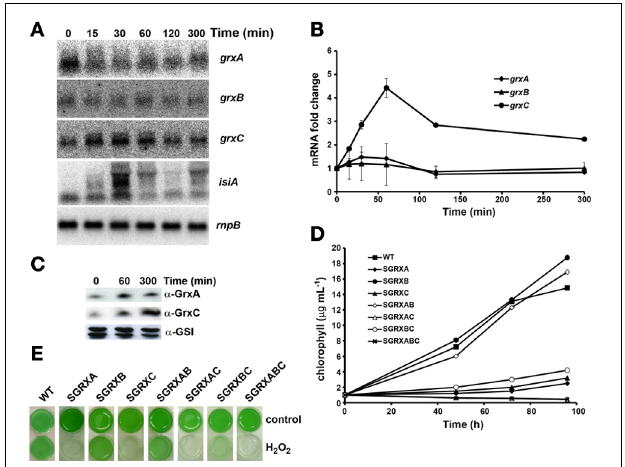
FIGURE 6 | Effect of different metals on glutaredoxin mutants growth. (A) Sensitivity of glutaredoxin mutants to metals. Tolerance of WT, SGRXA, SGRXB, SGRXC, SGRXAB, SGRXAC, SGRXBC, and SGRXABC strains to cadmium, copper, and nickel was examined. Tenfold serial dilutions of a 1 μ g chlorophyll mL − 1 of exponentially growing cells suspension were spotted onto BG11C supplemented with 2 μ M Cd, 3 μ M Cu, and 5 μ M Ni. Plates were photographed after 5 days of growth. (B) Sensitivity of glutaredoxin mutants to selenium. Tolerance of WT, SGRXA, SGRXB, SGRXC, SGRXAB, SGRXAC, SGRXBC, and SGRXABC strains to selenate (Na 2 SeO 4 ) or selenite (Na 2 SeO 3 ) was examined. Ten-fold serial dilutions of a 1 μ g chlorophyll mL − 1 of exponentially growing cells suspension were spotted onto BG11C supplemented with 30 μ M Na 2 SeO 3 or 30 μ M Na 2 SeO 4 . Plates were photographed after 5 days of